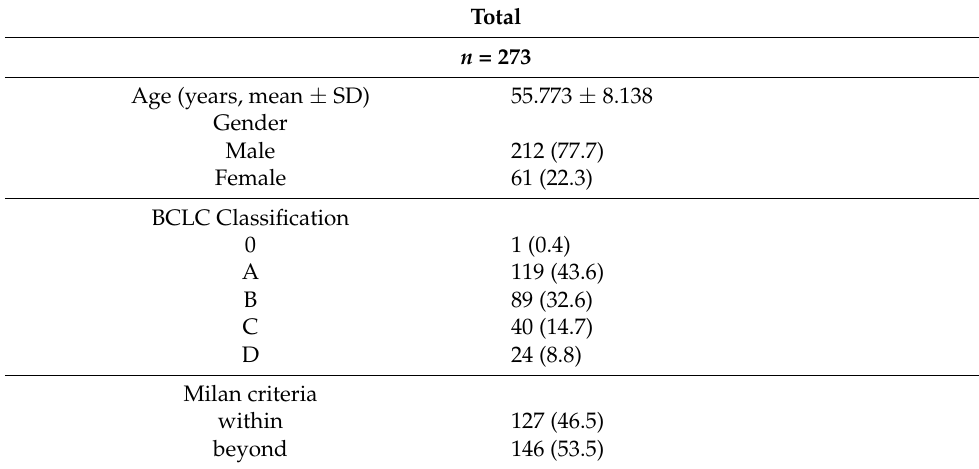
Table 1. Patient